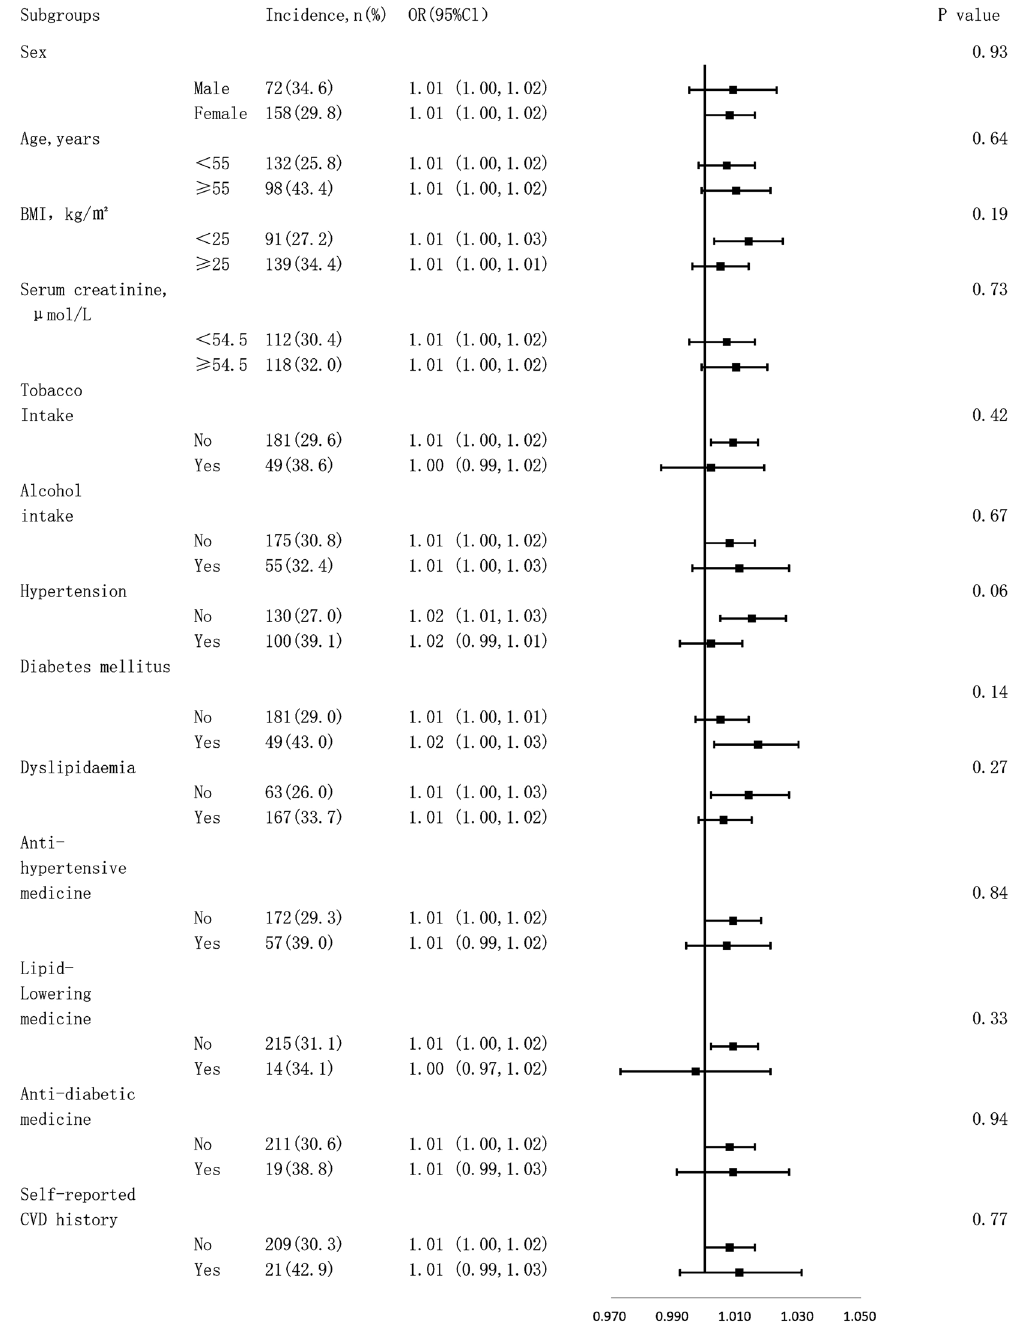
Figure 1. Subgroup analysis for the effect of ba-PWV on risk of carotid plaque formation after adjusting for confounding factors (Multivariate odd ratios [OR] and 95% confidence intervals [CI] are shown according to a ba-PWV value increase of 10